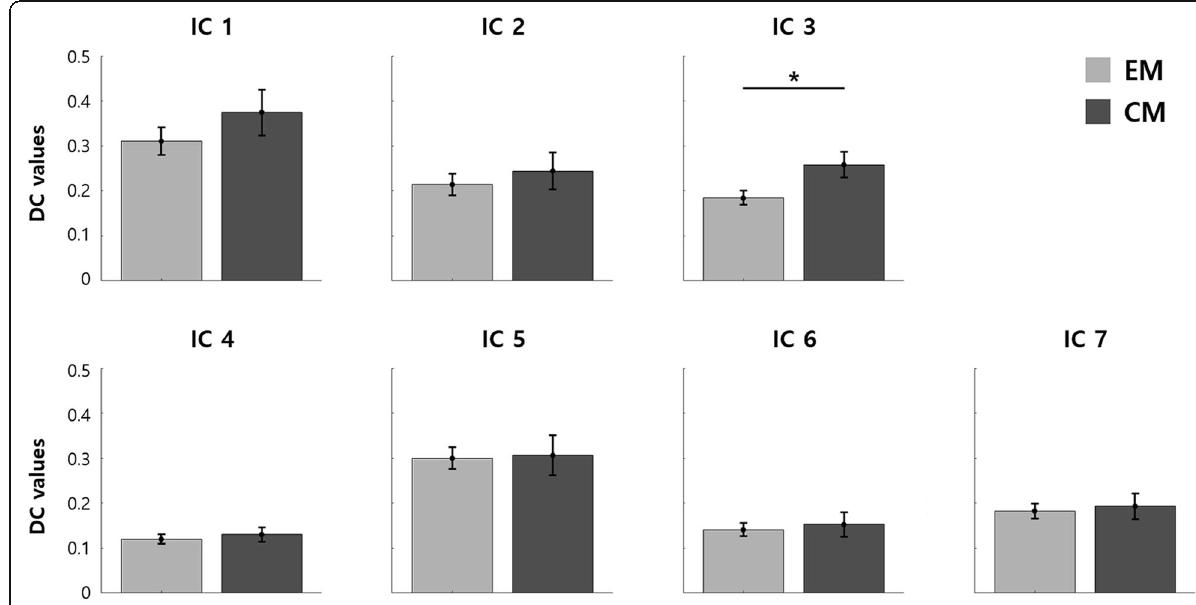
Fig. 4 Group comparison among identified resting-state networks. DC values were compared between EM and CM by using permutation tests with FDR. Each bar and error bar represent the mean and standard errors of mean,